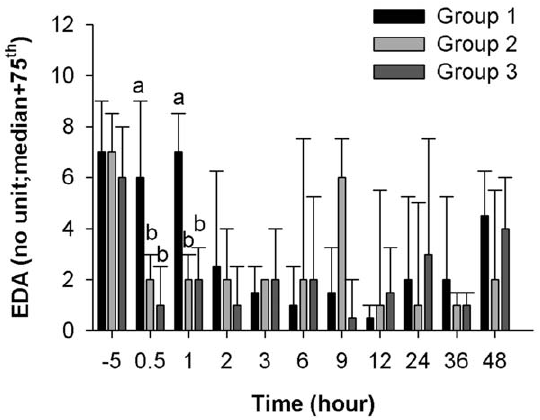
Figure 1. Electrodermal activity. EDA (no unit) by group over time. Data are presented as the median and 75 th percentile for groups of n=5 to 10 dogs over time. At each time point, different letters (higher case (a) or (b)) indicate significantly different values among treatment groups. Bonferroni-corrected alpha level was of 0.0015. doi:10.1371/journal.pone.0049480.g001 PLOS ONE |